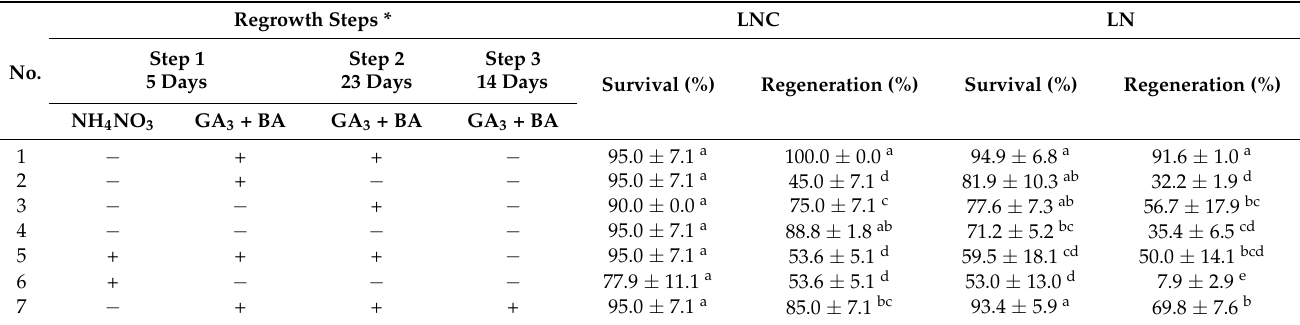
Table 3. Effect of ammonium nitrate and growth regulators at three regrowth steps on survival and regeneration of cryoprotected (LNC) and cryopreserved (LN) Pogostemon yatabeanus shoot tips.